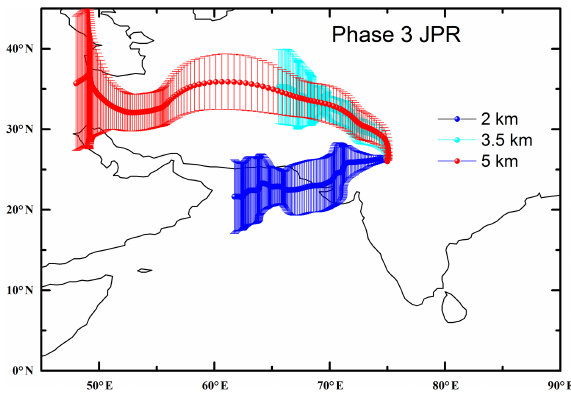
Figure 7. Back-trajectories showing the distinct air masses reaching Jaipur during the period of observation. The altitude indicates the height above sea level at which the air mass reaches the receptor